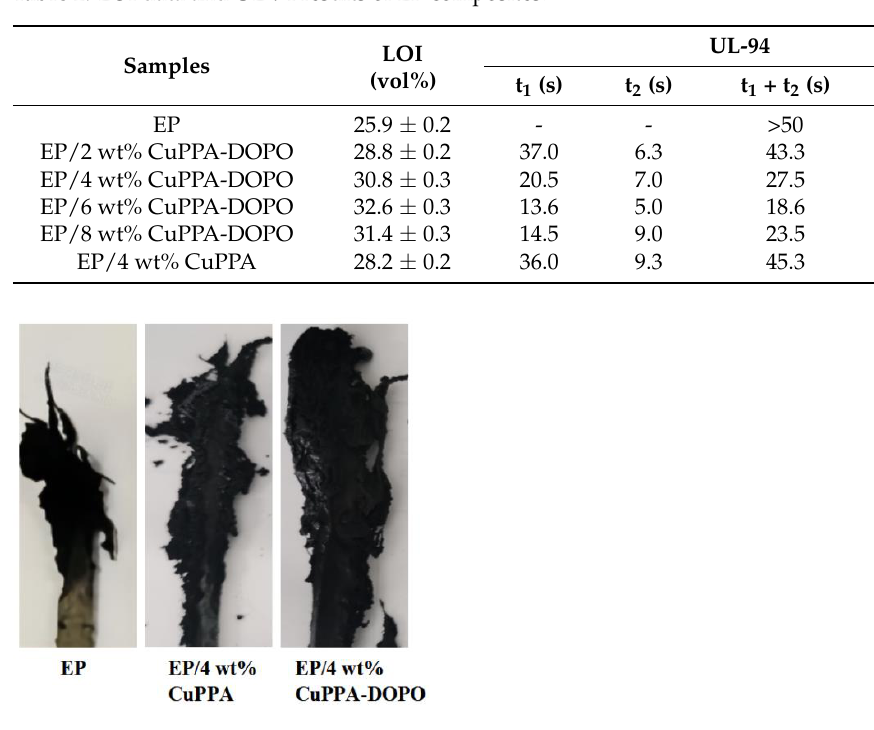
Figure 4. Photographs of pure EP and EP composites after LOI test.